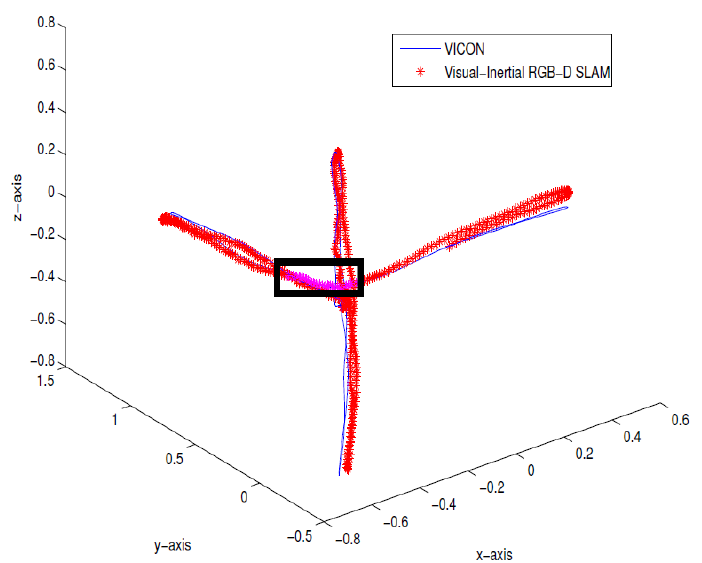
Figure 5. Indoor results of real-time Inertial-Kinect estimated trajectory (in red) compared with the Vicon ground truth (in blue). Directional constraint updates are simulated and shown in the rectangular